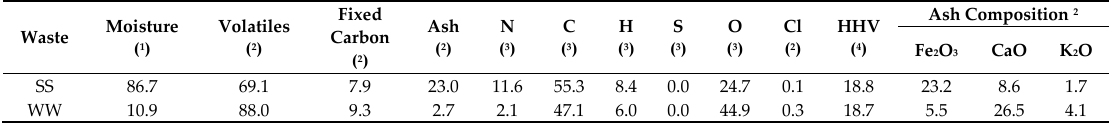
Table 1. Analysis of raw waste